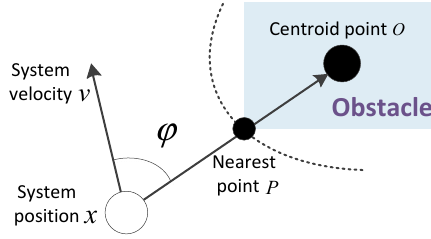
Figure 5. Diagram of an obstacle with non-negligible shape and size.